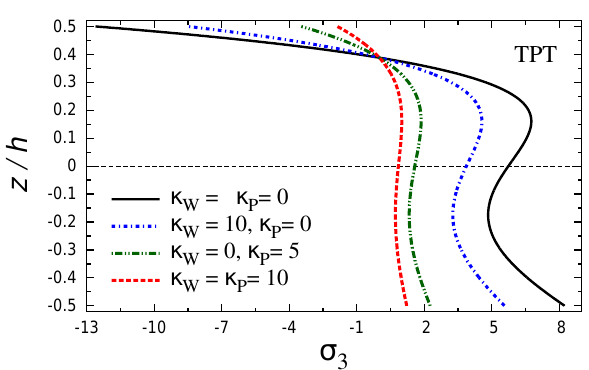
Figure 7: Through-the-thickness distributions of transverse normal stress σ 3 of the EG thick rectangular plate on elastic foundations ( b = 3 a , a = 4 h , k = 1.5) .